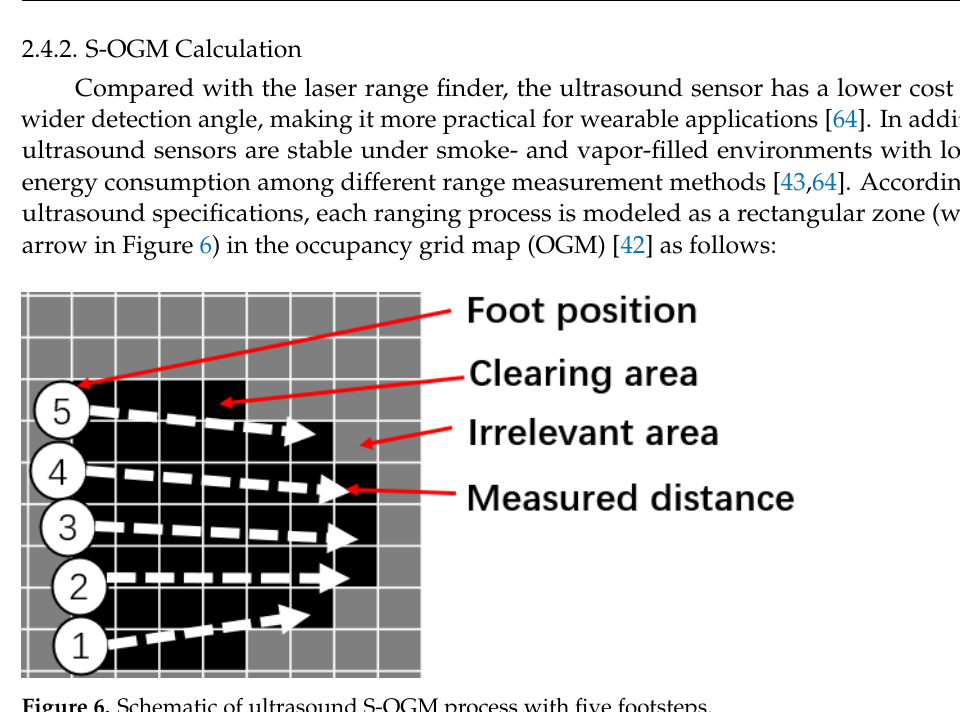
Figure 6. Schematic of ultrasound S-OGM process with five footsteps. The single grid cells of the map are categorized as empty (black) or irrelevant (gray) areas. The S-OGM algorithm is defined as: